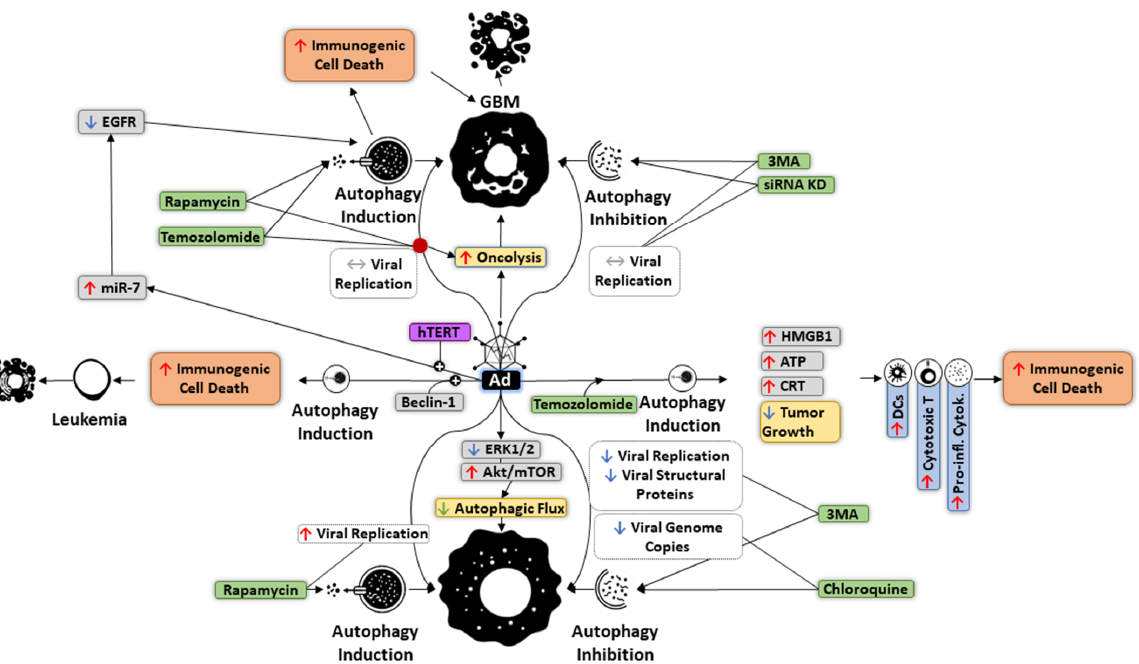
Figure 3. Effect of autophagy on the replication of oncolytic adenovirus (Ad). Although the entry of Ad decreases autophagic flux by affecting Erk1/2 and Akt/mTOR pathways, induction of autophagy with rapamycin can promote viral replication in cancer cells. Arming Ad with BECN1 and hTERT promoters results in autophagic cell death through different mechanisms in glioblastoma (GBM) and leukemia, respectively. Moreover, Ad-mediated oncolysis in GBM can be boosted by autophagy activation without significant impact on viral replication. Combination of Ad and temozolomide induces autophagy, which mediates immunogenic cell death via eliciting dendritic cells, cytotoxic T lymphocytes, and pro-inflammatory cytokines.